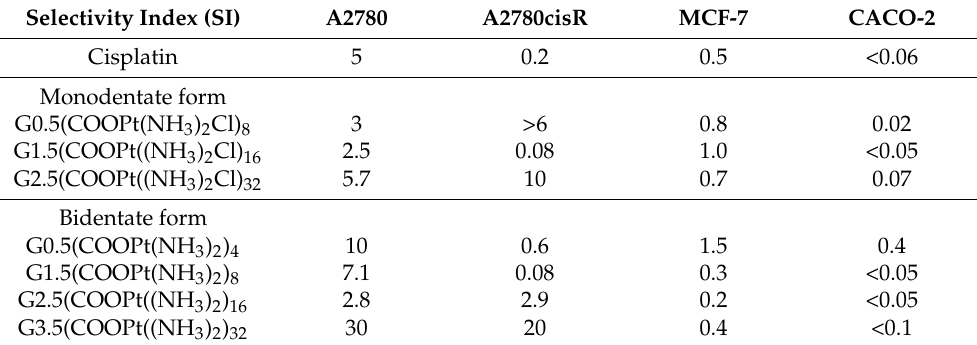
Table 5. Selectivity index (SI) for cisplatin and the metallodendrimers